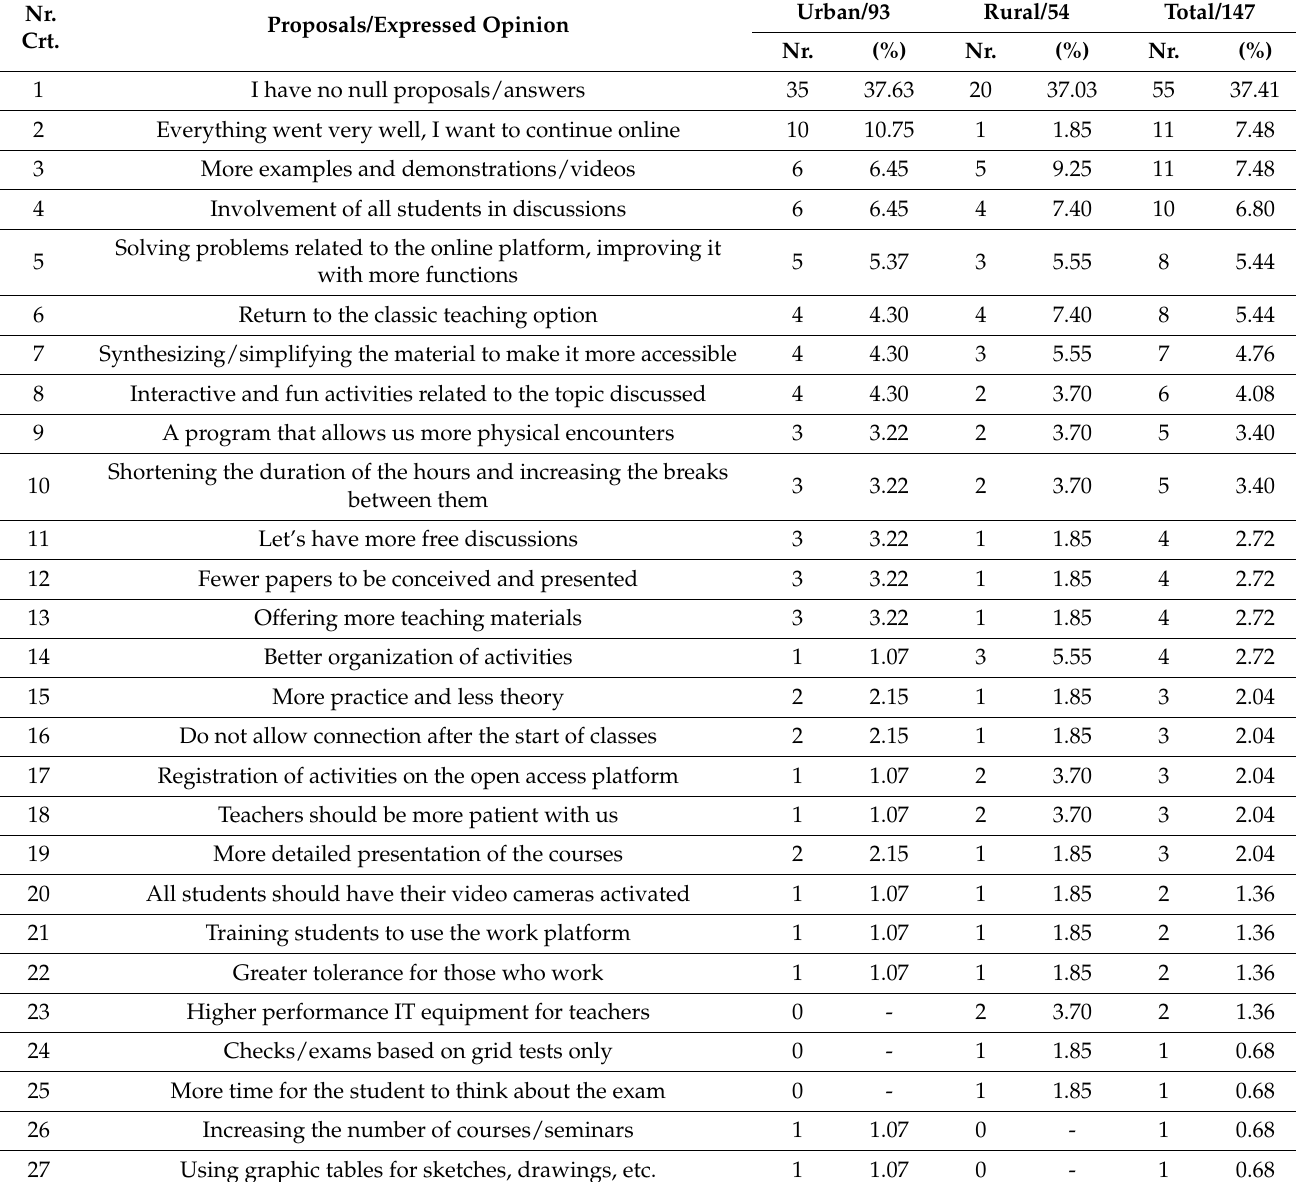
Table 7. Students’ proposals for streamlining online teaching